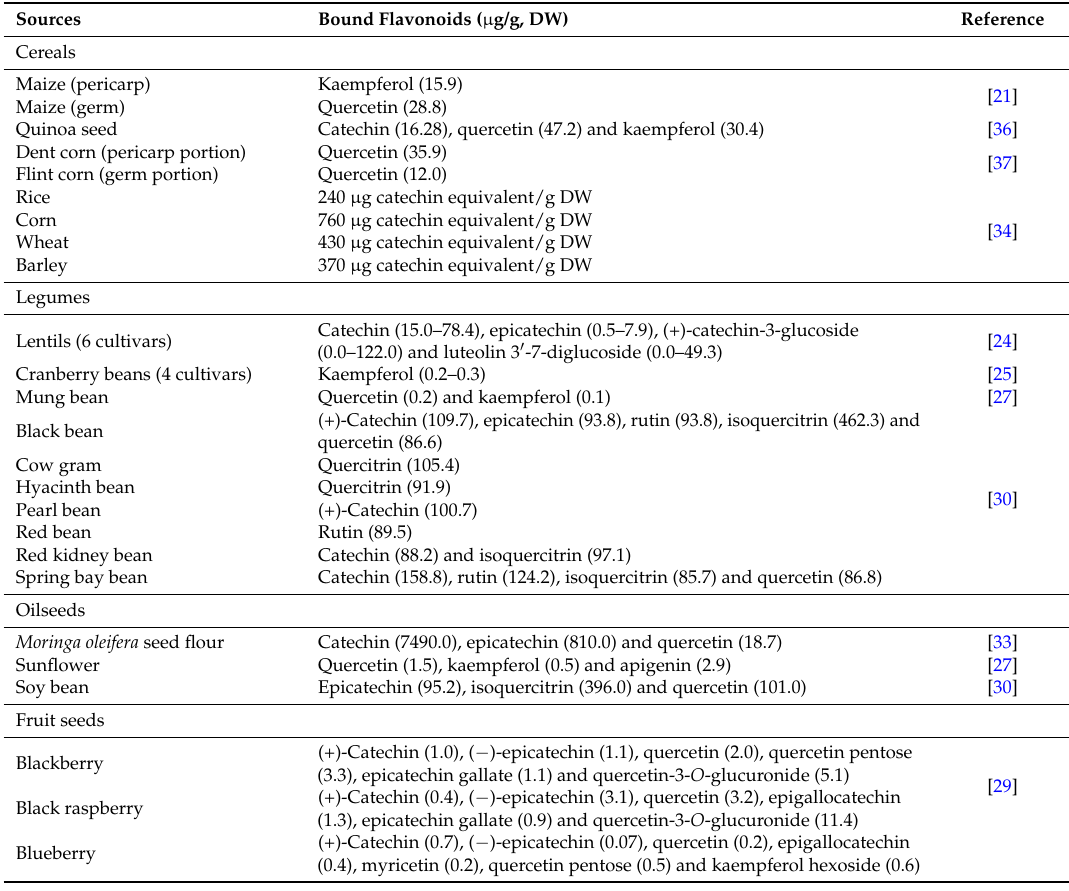
Table 2. Insoluble-bound flavonoids in cereals, legumes and other